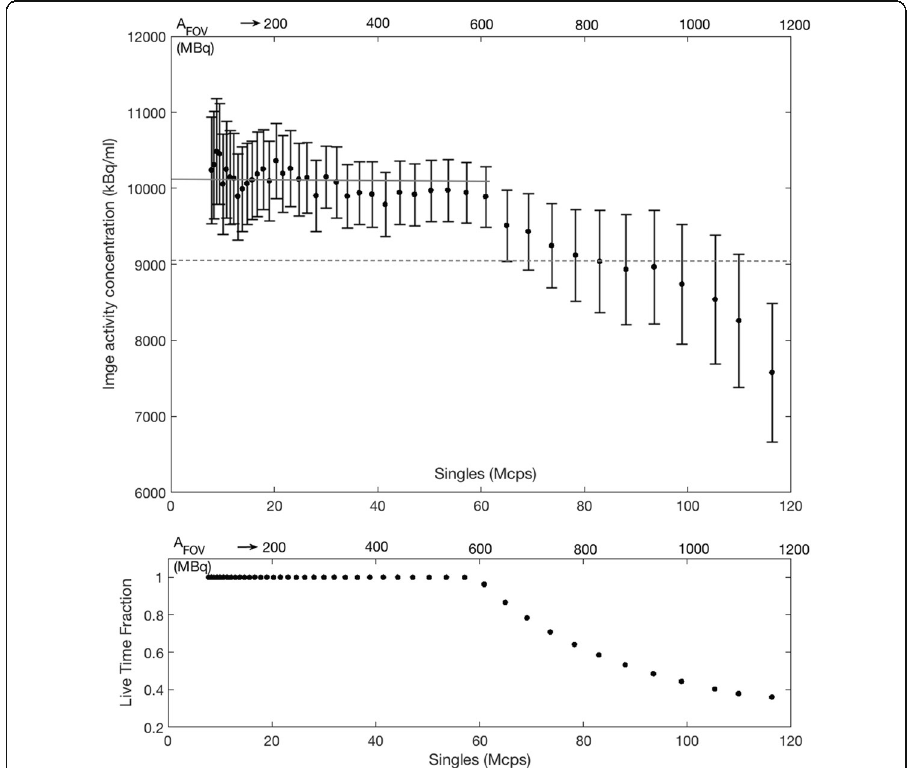
Fig. 2 Top — The mean activity concentration of the myocardial compartment of the phantom plotted against A FOV and singles rate showing evidence of count-rate losses above approximately 60 Mcps. The solid grey line shows the average activity concentration at count rates < 60 Mcps. The dashed line shows 10% bias from this average activity concentration reached at singles rates > 60 Mcps. Error bars represent 1 standard deviation of the mean activity concentration of the volume of interest. Bottom — Scanner live-time fraction against A FOV and singles rate averaged over each 5-s frame showing the effect of high count rates on the ability to process true coincidence